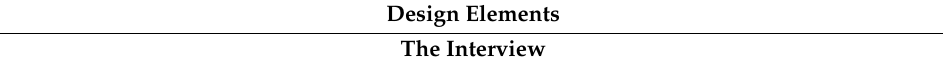
Table 1. Overview of the design principles used for the narrative quality